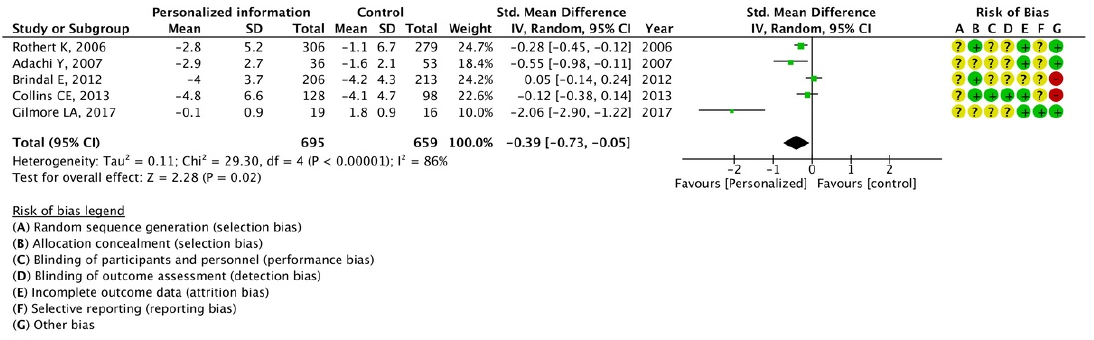
Figure 5. Meta-analysis for mean weight change with or without personalized information using 5 articles [16,17,26,31,50]. The forest plot shows standardized mean differences (SMD) for each article